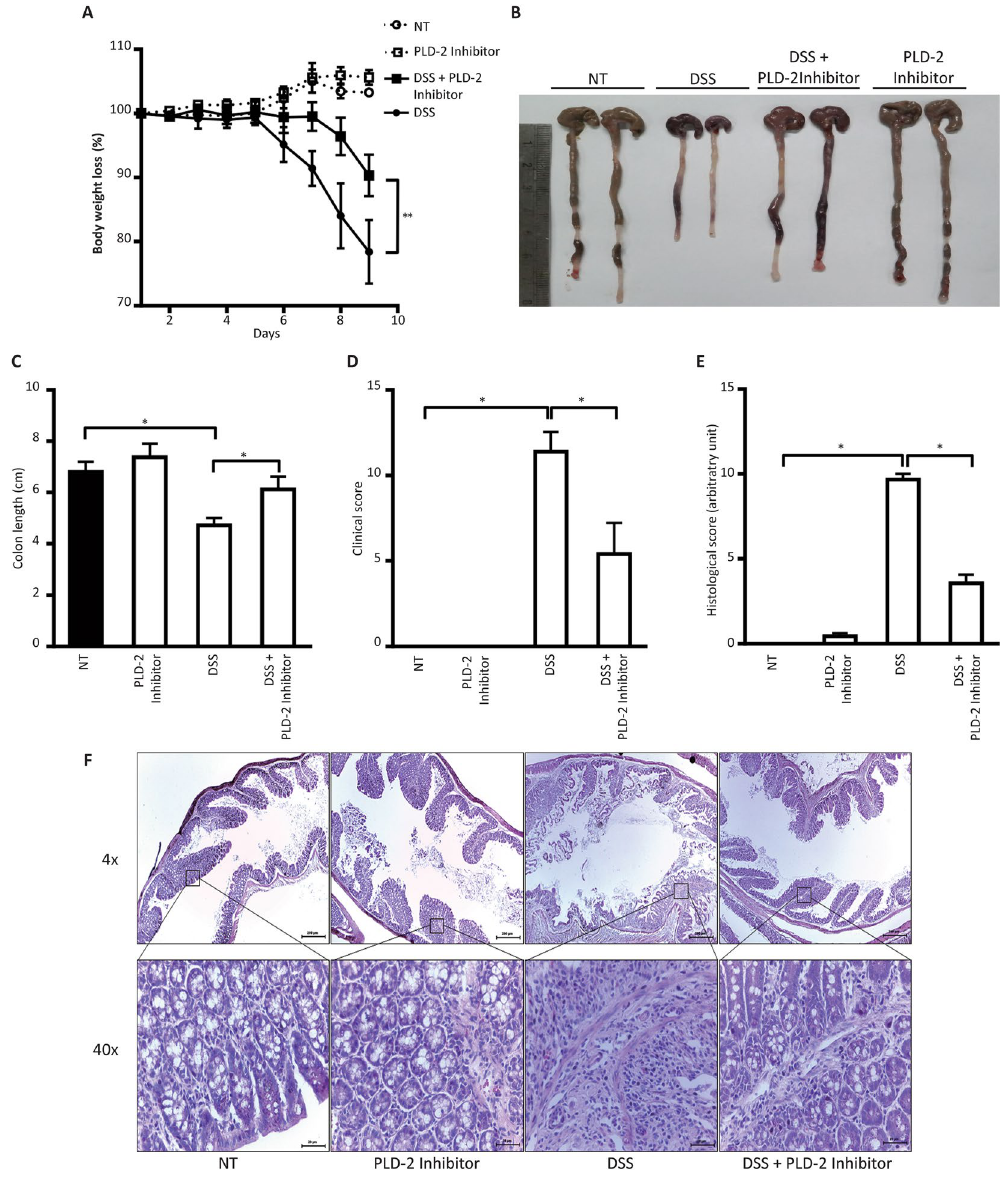
Figure 6. Chemical inhibitor of PLD2 phenocopies the effect of PLD2 knockout in intestinal epithelial cells and protects mice from DSS-induced colitis. ( A ) C57BL/6 mice were injected with 10 mg/kg of PLD2 inhibitor, VU0364739. HCl, every other day, thrice, before the start of the DSS treatment, and during the DSS treatment for the indicated times. Body weights of the control groups, DSS-treated, and PLD2 inhibitor-treated mice were monitored every day and plotted as the percentage of change in body weight. ( B ) Gross imaging of colons from the control groups, DSS-treated, and DSS + PLD2 inhibitor-treated mice. ( C ) Colon lengths of the control groups, DSS-treated, and DSS + PLD2 inhibitor-treated mice. ( D ) The mice were scored using clinical phenotypes such as stool consistency and rectal bleeding. ( E ) Histological score of H&E-stained colon histograms. ( F ) H&E-stained colon sections from the control, DSS-treated, and DSS + PLD2 inhibitor-treated mice, showing damage to the intestinal epithelial layer. Scale bar: 200 µ m, 20 µ m. All data are shown as the mean ± SEM. * p < 0.05, ** p <